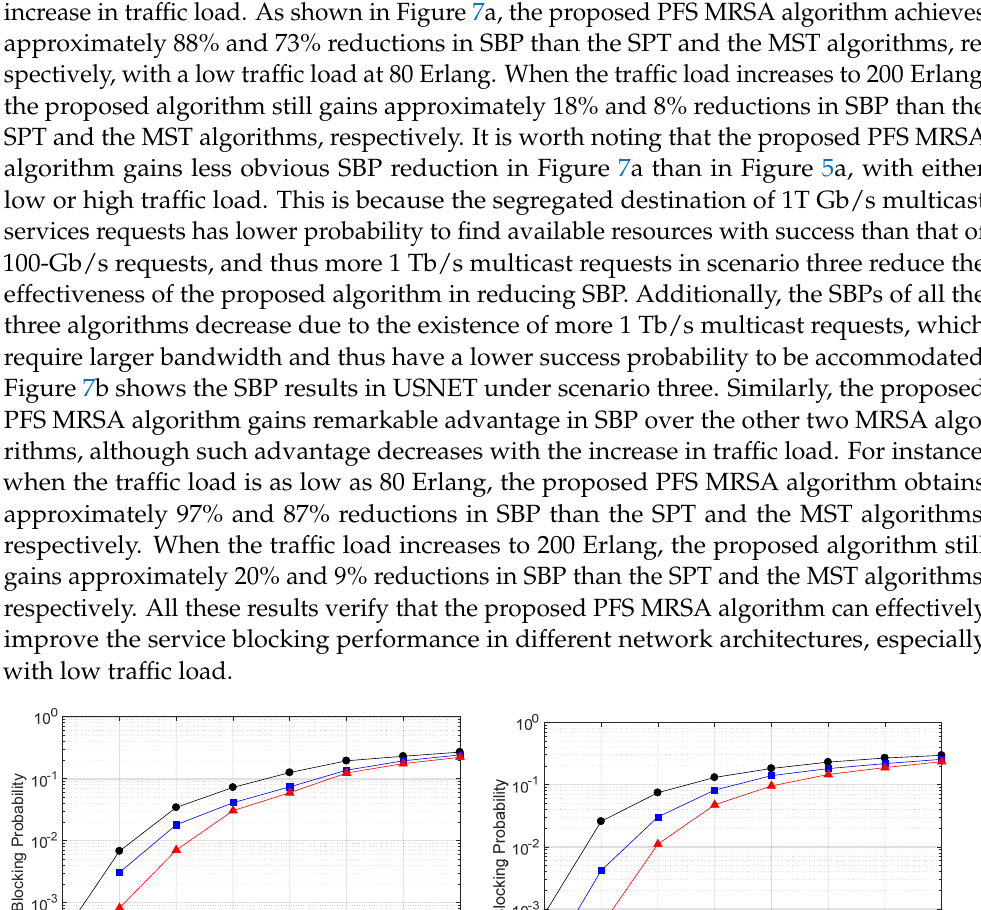
Table 1. Simulation results on service blocking probability in different scenarios when the traffic load is 200 Erlang.